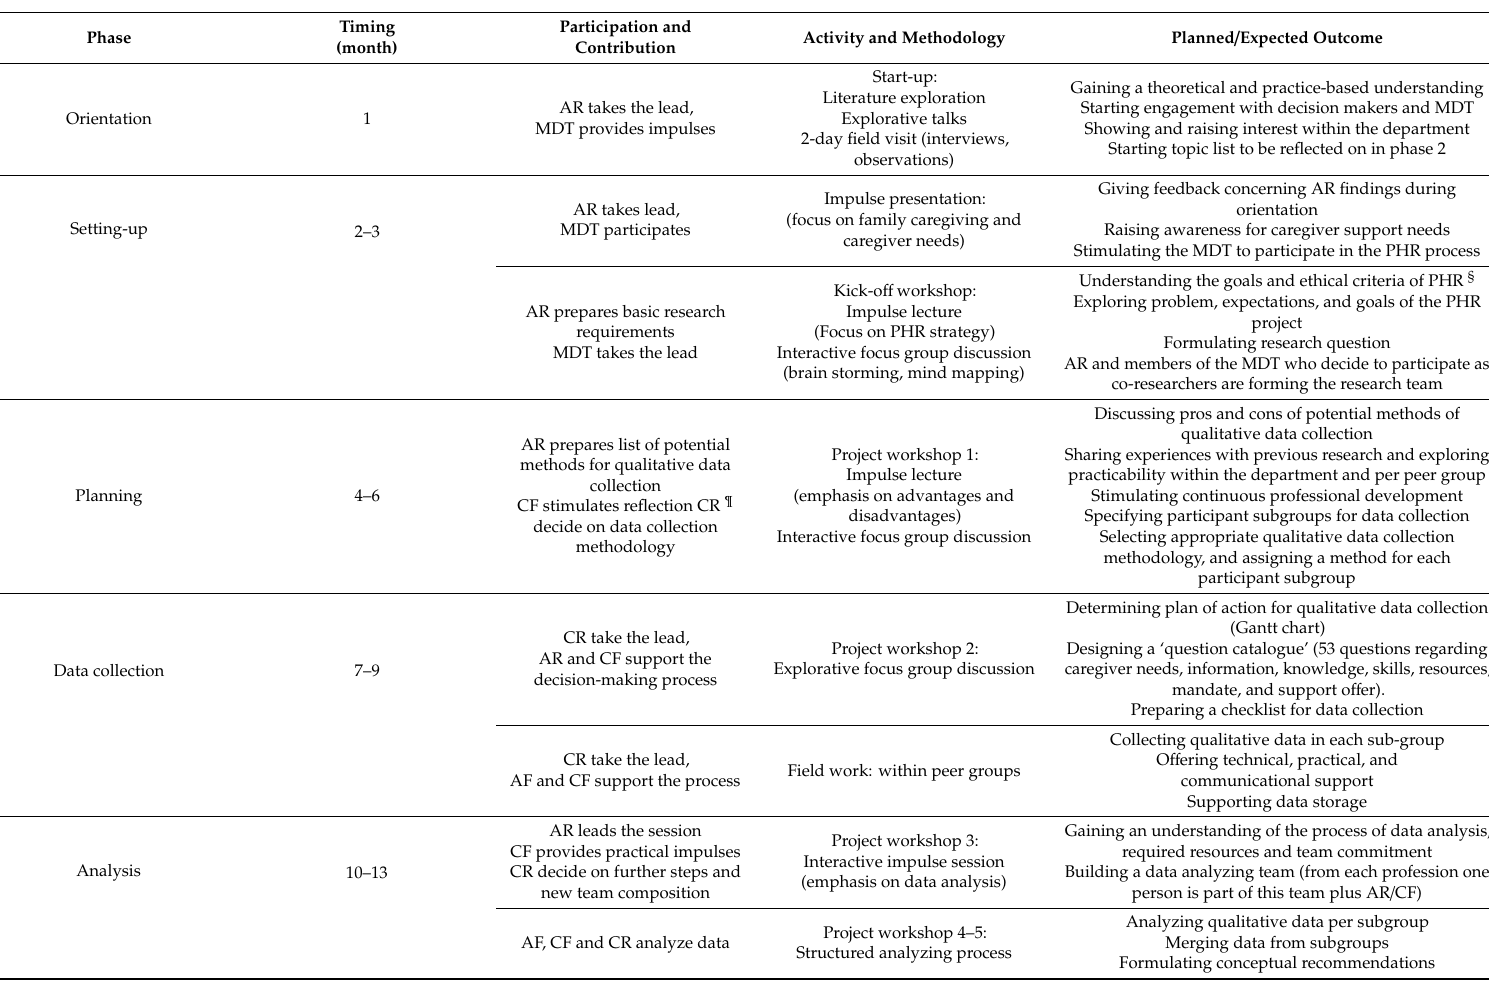
Table 1. The project management plan of the PHR study on actual state and needs of the multidisciplinary geriatric team with respect to family caregiver support, ordered by phase in the life cycle. The activities and methodology and planned / expected outcomes were entered during the